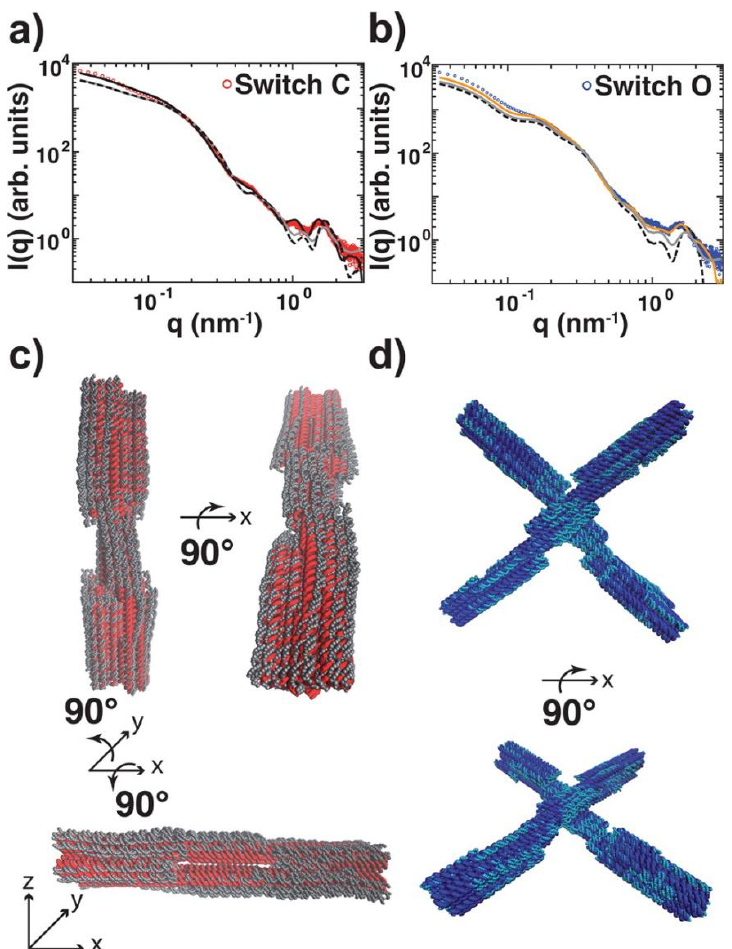
Figure 4. ( a ) and ( b ) depict the mode-based refinement of a DNA switch structure against small-angle X-ray scattering (SAXS) data. ( a ) Experimental SAXS data for the DNA switch in the closed, linear conformation and ( b ) the open, X-shaped conformation are shown as red and blue circles, respectively, against the scattering profile predicted by preliminary models in CanDo (dashed black lines) and CRYSOL software (gray lines) [71]. The preliminary structures of the ( c ) open and ( d ) closed switch conformations are shown as red and blue cylinders with the refined structures shown as gray and light-blue orbs, respectively. Reprinted (adapted) with permission from Bruetzel, L.K.; et al. Conformational Changes and Flexibility of DNA Devices Observed by Small-Angle X-ray Scattering.